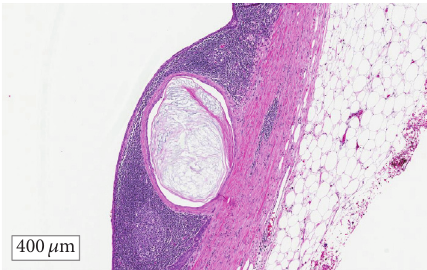
Figure 2: Lymphoepithelial cyst, with squamous cell lining without evidence for mucinous neoplasm or